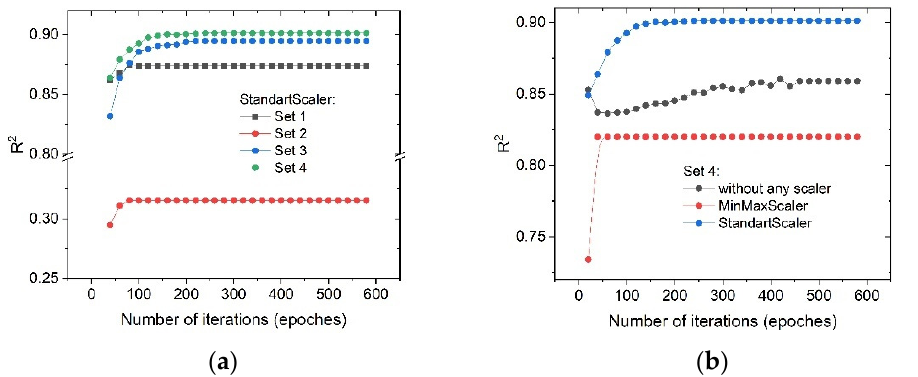
Figure 3. The initial ( a ), normalized ( b ), and centralized ( c ) values of training sample parameters.